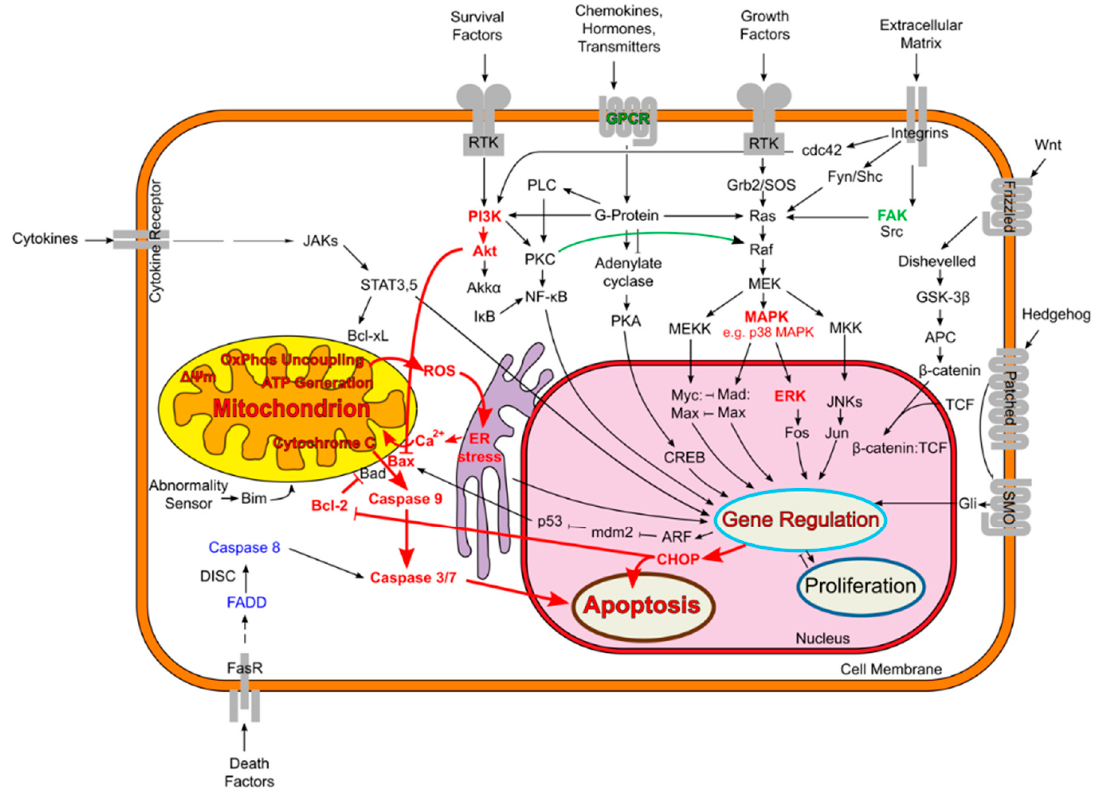
Figure 1. Schematic illustration of relevant intracellular signal transduction pathways of local anesthetic-induced toxicity. Signaling pathways and mediators that are conveying a toxicity-increasing effect are marked in red color, while those that are involved in protective mechanisms are highlighted green. Blue colored elements were proven not to be affected, while the role of non-highlighted (black) elements remains unclear or not investigated. Local anesthetic neurotoxicity can affect multiple signaling pathways and ultimately leads to the activations of mitochondrial signaling pathway of apoptosis, which is also referred to as the intrinsic pathway of apoptosis. This pathway involves mitochondrial injury and dysfunction, loss of mitochondrial membrane potential ( ∆Ψ m ), and the oligomerization of Bax protein in the outer mitochondrial membrane, which leads to the release of apoptosis-inducing mediators like cytochrome c. This leads to the formation of the apoptosome, which comprises caspase-9 and other factors. The apoptosome, in turn, activates the effector caspases 3 and 7 and therefore converges into a signaling cascade, which ultimately leads to specific nuclear DNA-fragmentation. Abbreviations: adenomatous polyposis coli tumor-suppressor gene (APC); alternate reading frame tumor suppressor protein (ARF); CCAAT-enhancer-binding protein homologous protein (CHOP); endoplasmatic reticulum (ER); extracellular-signal-regulated kinase (ERK); Fas-associated protein with Death Domain (FADD); focal adhesion kinase (FAK); mitogen-activated protein kinase (MAPK); reactive oxygen species (ROS); Smoothened protein (Smo) T-cell factor (TCF). This figure was prepared based on a previous figure by Hanahan and Weinberg [63] and a previously modified version (http://en.wikipedia.org/wiki/File:Signal_transduction_v1.png).